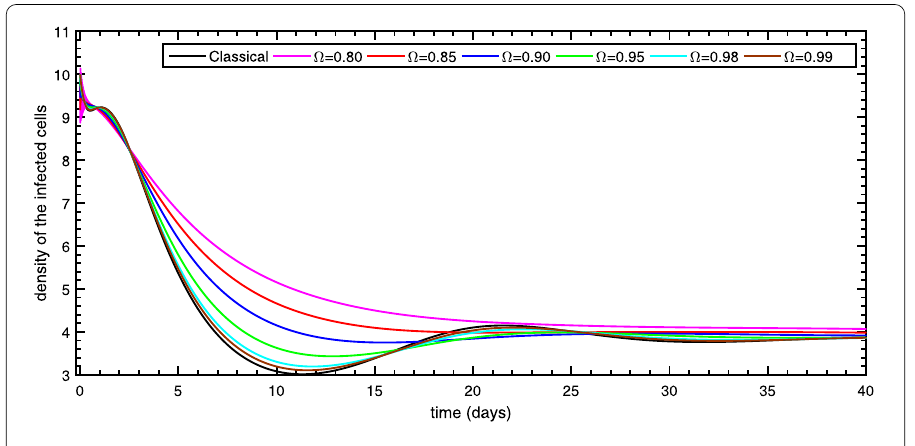
Figure 3 Density of the infected cells with initial conditions X (0) = 10, Y (0) = 10, V (0) = 0 for t ∈ [0,40]